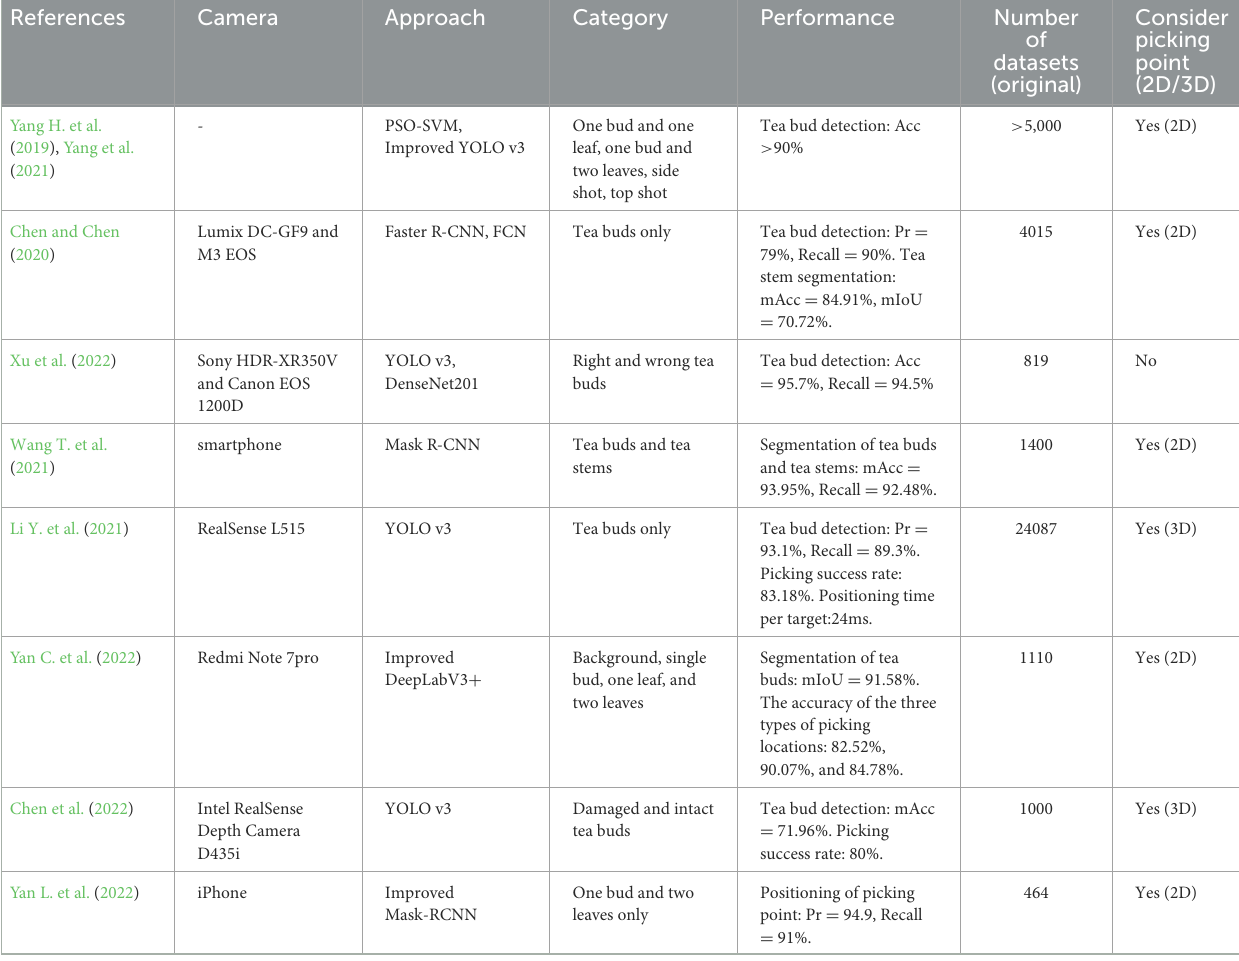
TABLE 2 Summary of computer vision and machine learning in tea harvesting